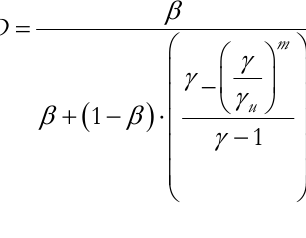
: Parameter characterizing the effect of the damage on the mechanical characteristics of the